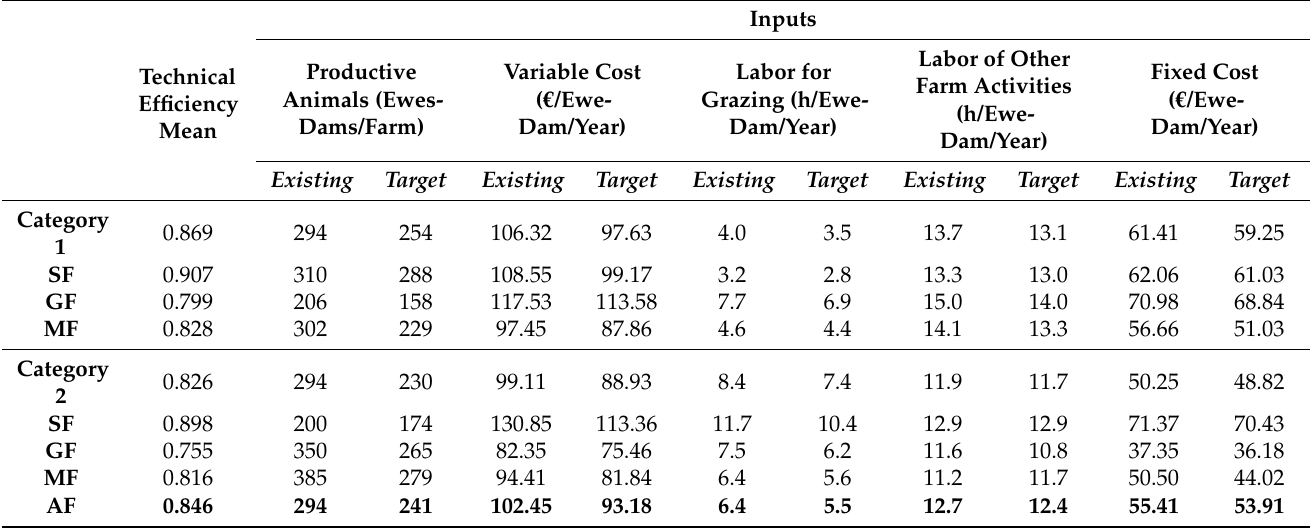
Table 6. Comparison of inputs between existing and optimal